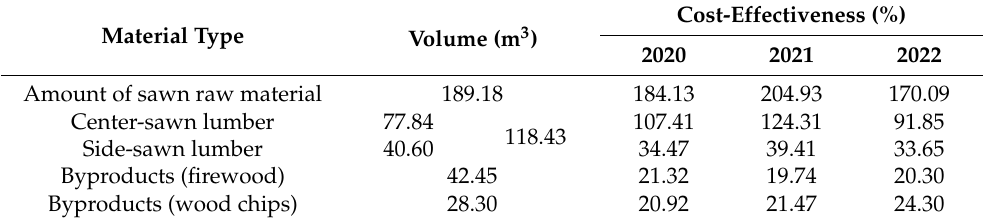
Table 9. Cost-effectiveness ( E p ) of the sawing process according to the variant “A”.